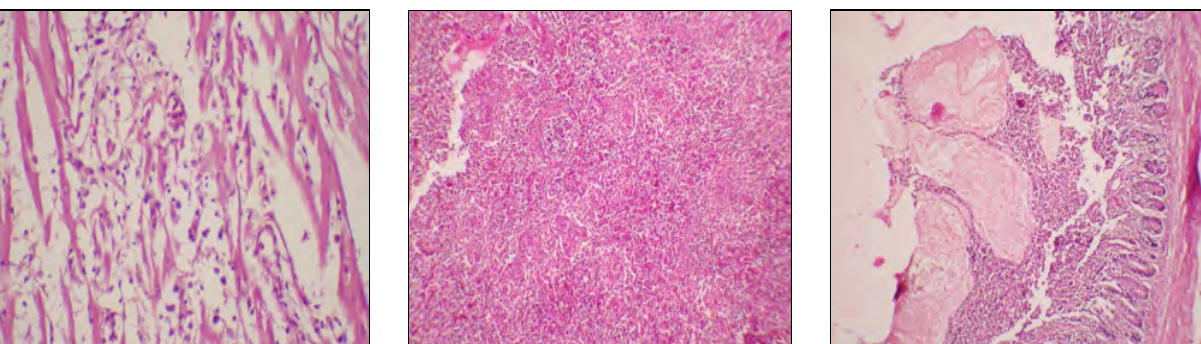
Figure-3. Liver: Showing large area of co- agulative necrosis, surrounded by leucocytes. ( Salmonella Gallinarum infection) H & E x 33